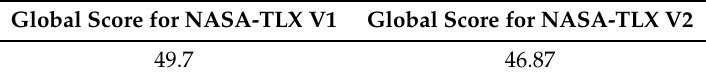
Table 12. Global score results of the NASA-TLX